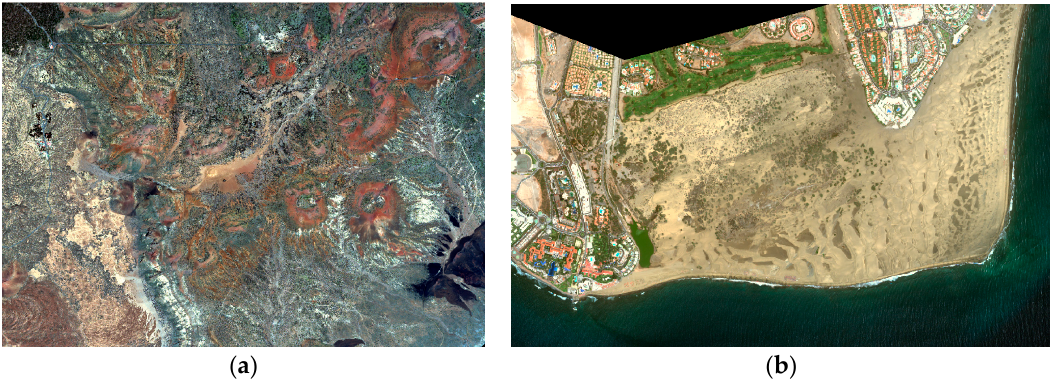
Figure 4. Worldview-2 satellite imagery used: ( a ) Teide National Park; ( b ) Maspalomas Special Natural Reserve.